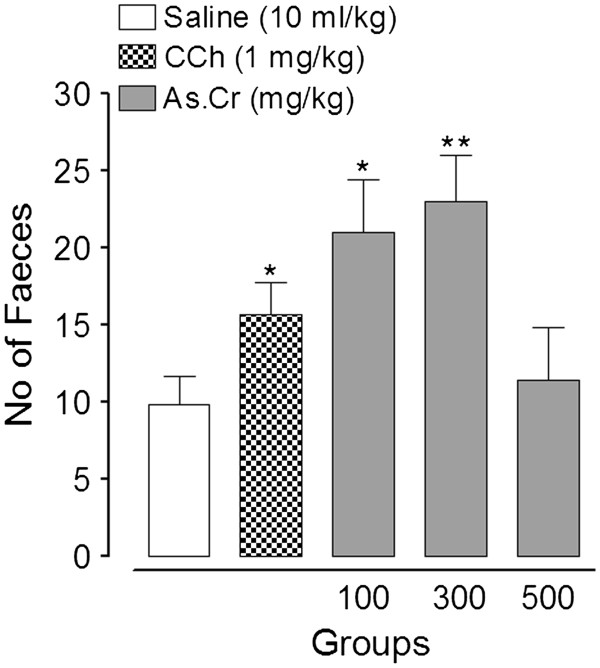
Laxative effect of variousconcentrations of crude extractofA. spinosus(As.Cr) and carbachol (CCh)in healthy mice. *p < 0.05, **p < 0.01 vs. Saline.